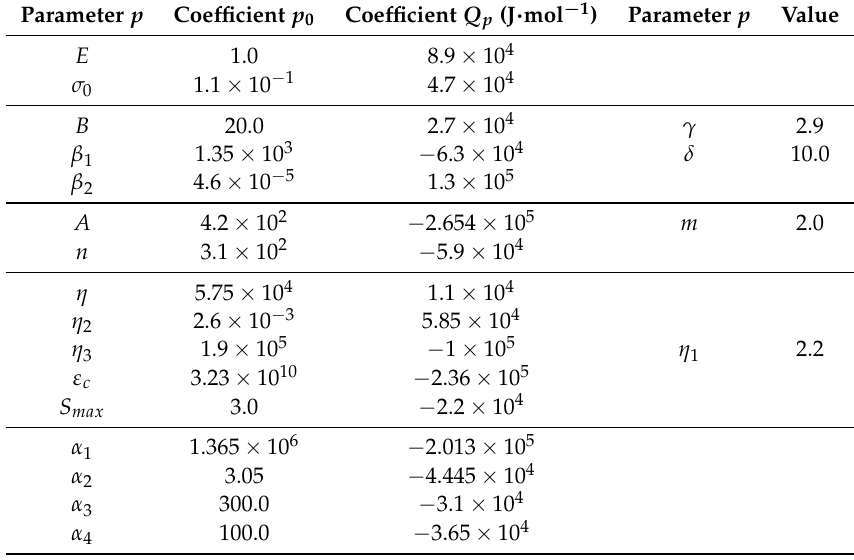
Table 2 refers to the values of all the model parameters. Table 2. Model parameters in conjunction with Equations (9) and (10), Temperature-dependent parameters ( left ) and constant parameters ( right